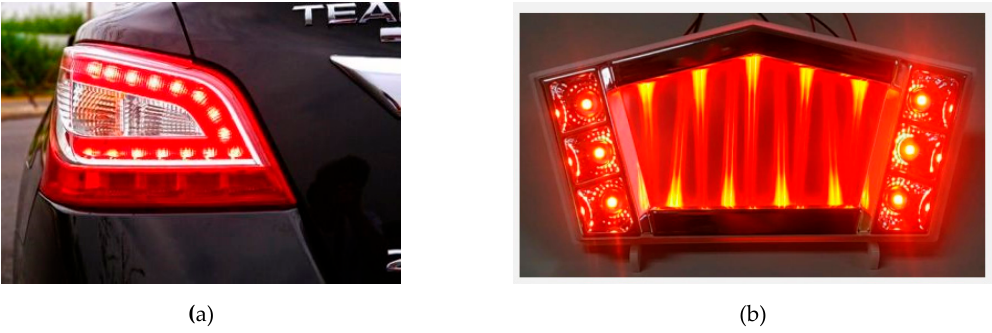
Figure 1. The combination lamp of the car with LED technology ( a ) the traditional design; ( b ) the new design with three dimensional lighting array.